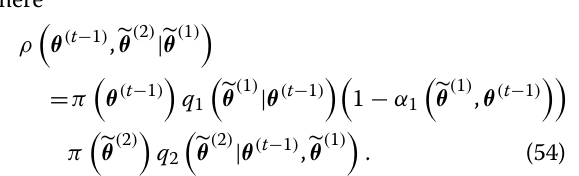
Algorithm 17. Unlike the multiple try schemes described in Section 5.1, in the DRM sampler the candidates are not compared together at the same time, but each candidate